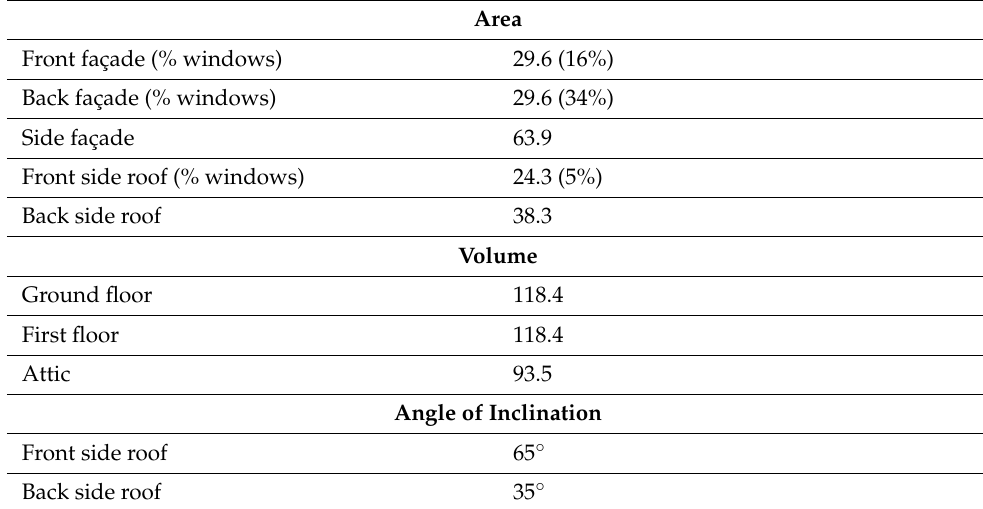
Table 3. Geometrical characteristics of the reference building.